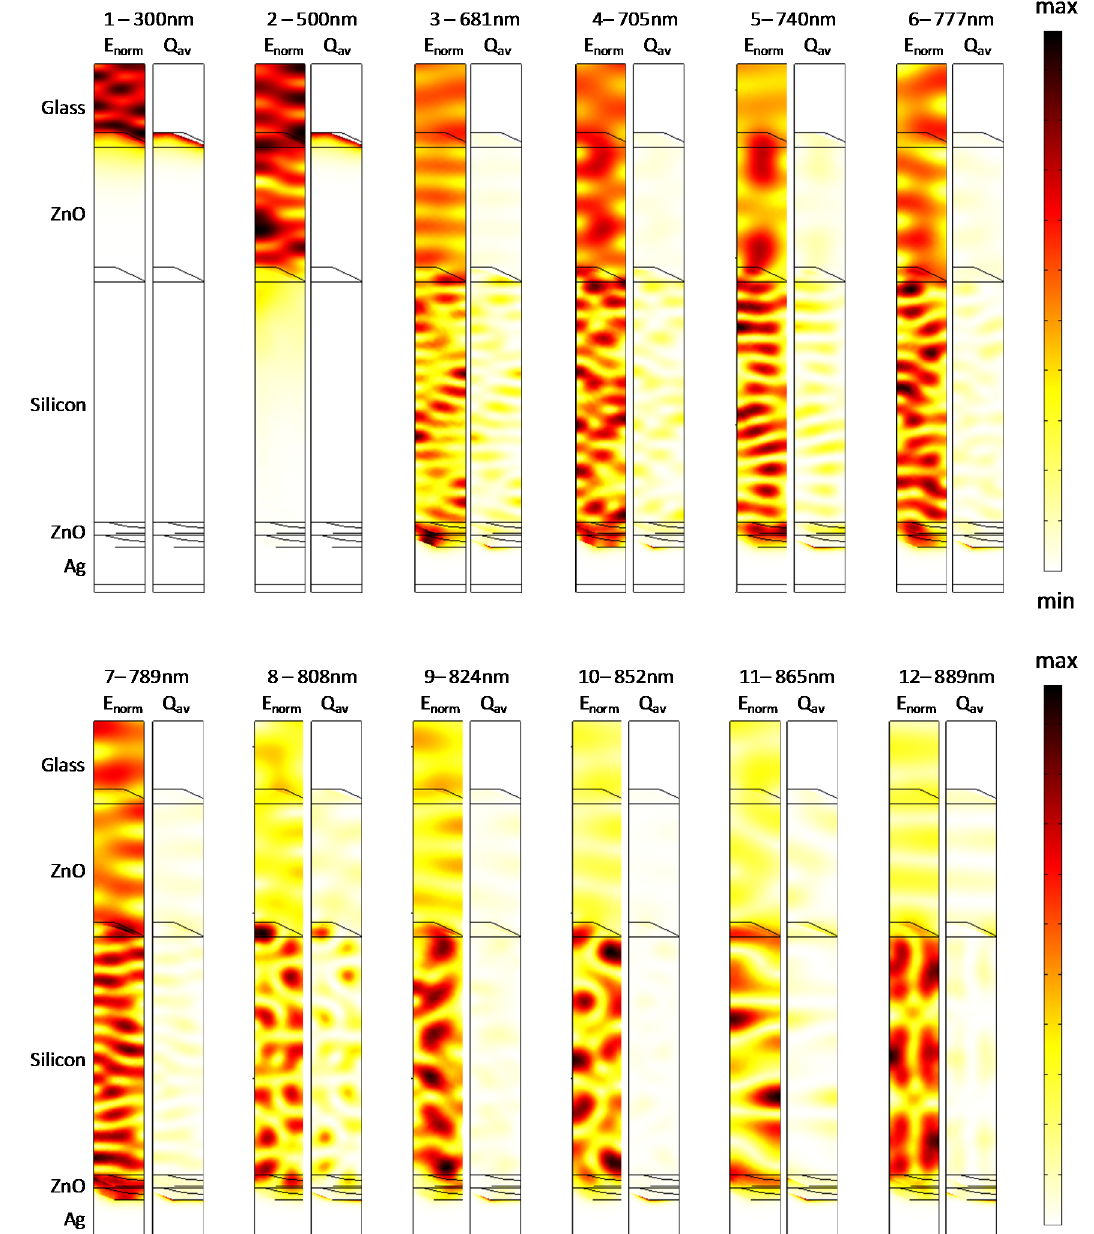
Figure 15. Normalized electric field and the resistive heating field distributions along an orthogonal slice in the zx plane for the cells with a 1500-nm-thick silicon layer at individual